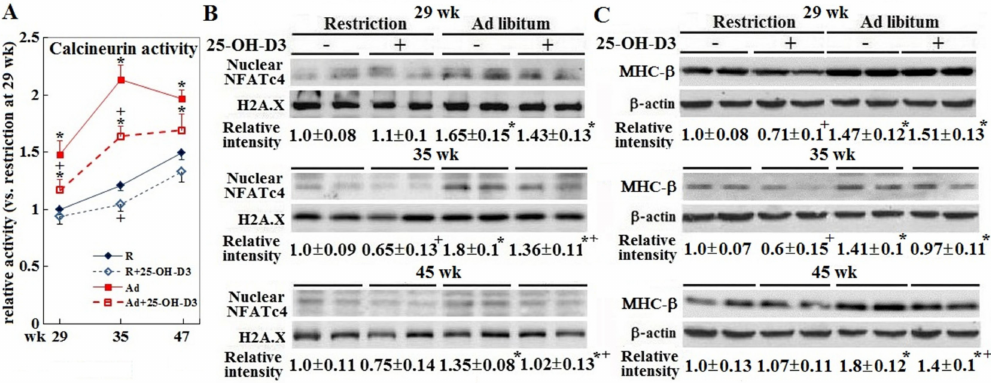
Figure 4. E ff ect of dietary 25-OH-D3 supplementation on cardiac hypertrophic remodeling in broiler breeder hens provided with restricted or ad libitum feed intake. At age of 29, 35, and 47 weeks, 4, 7, and 7 hens from each group were randomly selected for tissue collection. Of the hearts collected at 35 and 47 weeks, 4 hearts from each group were used for calcineurin activity analysis (panel A ), and NFATc4 activation and MHC- β expression (panels B , C ) through Western blot study. The remaining 3 hearts were used for histological studies. Results of Western blot studies were normalized to H2A.X or β -actin. All results are expressed as ratios relative to R- hens at 29 weeks. *; significant di ff erence by ad libitum feeding (vs. corresponding R hens, p < 0.05). + ; significant di ff erence by 25-OH-D3 inclusion (vs. R or Ad hens, p < 0.05). R; restriction, Ad; ad libitum, 25-OH-D3; 25-hydroxycholecalciferol, H2A.X;